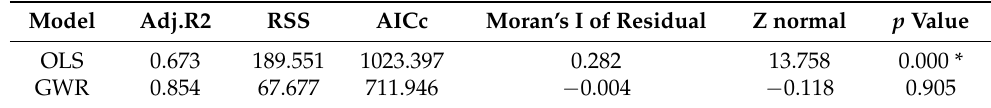
Table 5. The diagnostic information of two